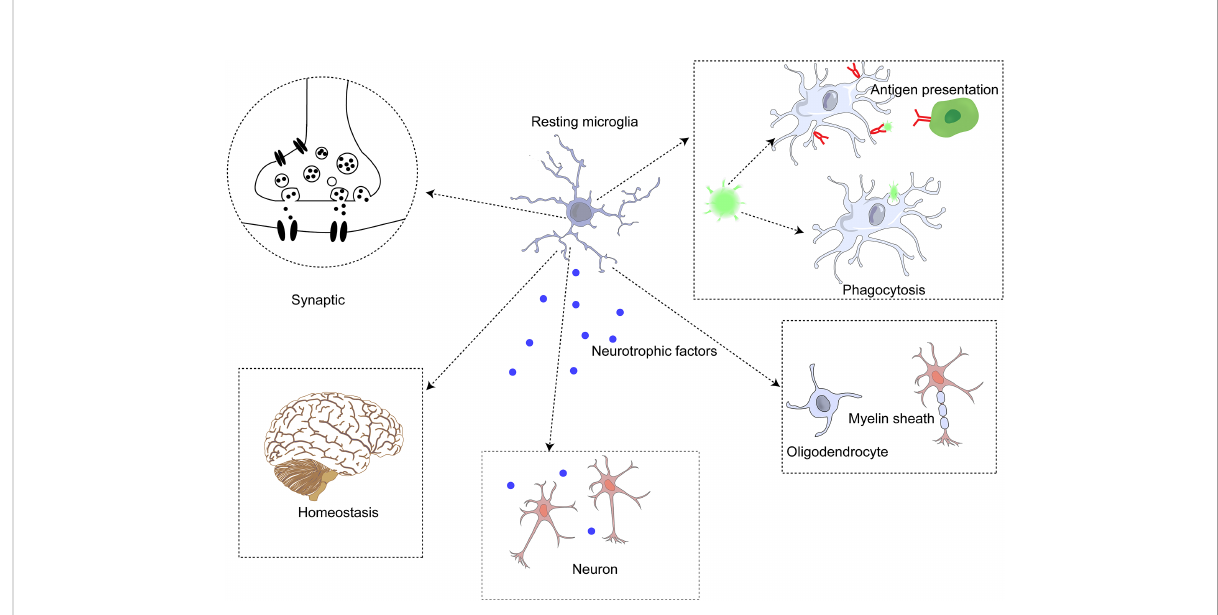
FIGURE 2 Microglia perform functions in the central nervous system.